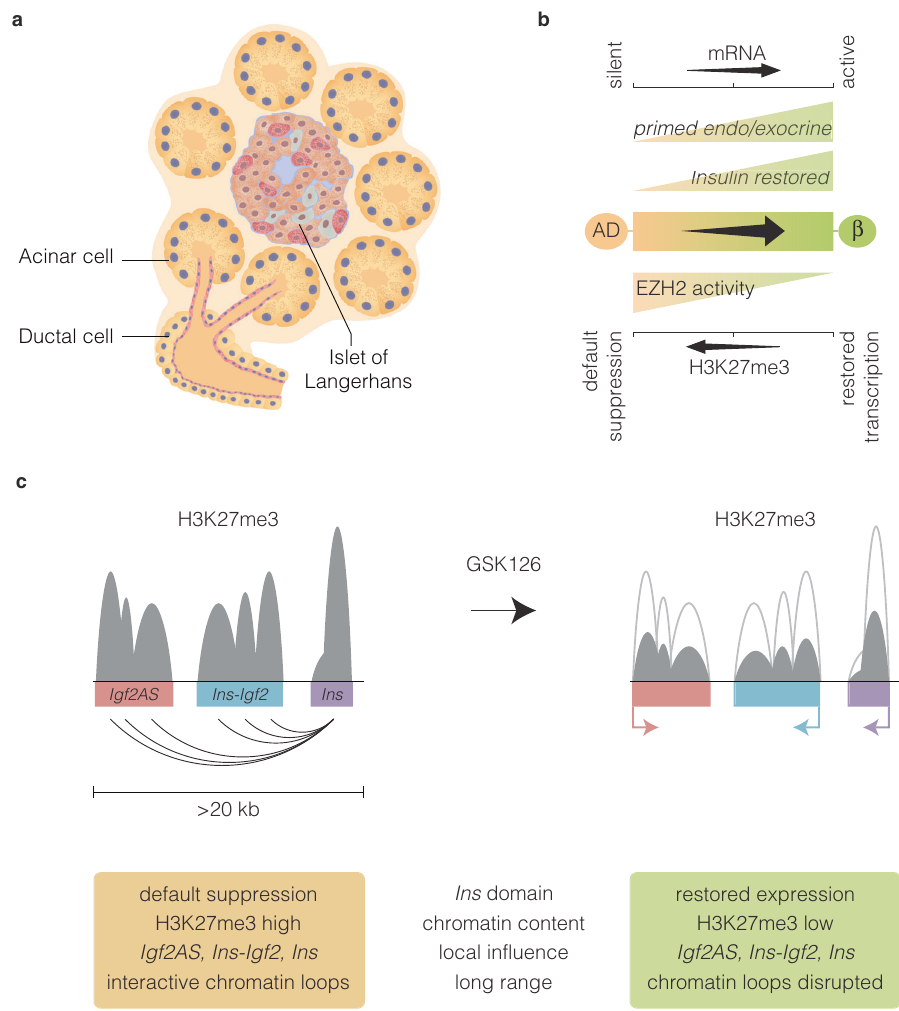
Fig. 6 Schematic representation of pancreatic progenitor differentiation and the refractory in fl uence of H3K27me3 content on the insulin chromatin domain in human exocrine cells. a Organisation of the human endocrine and exocrine pancreas showing the main pancreatic ductal tree connecting the acinar bundle. b The inability to in fl uence transcriptional expression in the exocrine and endocrine pancreas is in accordance with default transcriptional suppression mediated by EZH2 dependent H3K27me3. Conversion of default repression state in the acinar and ductal (AD) cells is in fl uenced by pharmacological inhibition of EZH2 by GSK126 to prime β -cell lineage regeneration and restore insulin expression. c Proposed model of the Ins chromatin domain in pancreatic cells. Default transcriptional suppression is characterised with H3K27me3 rich regions can in fl uence chromatin conformation, and suppress the expression of Ins, Igf2AS and Ins-Igf2 genes postulated by long-distance chromatinised-looping. We propose GSK126 attenuates EZH2 activity to in fl uence local H3K27me3 chromatin content and long- distance interactions that function on the Ins chromatin domain and gene